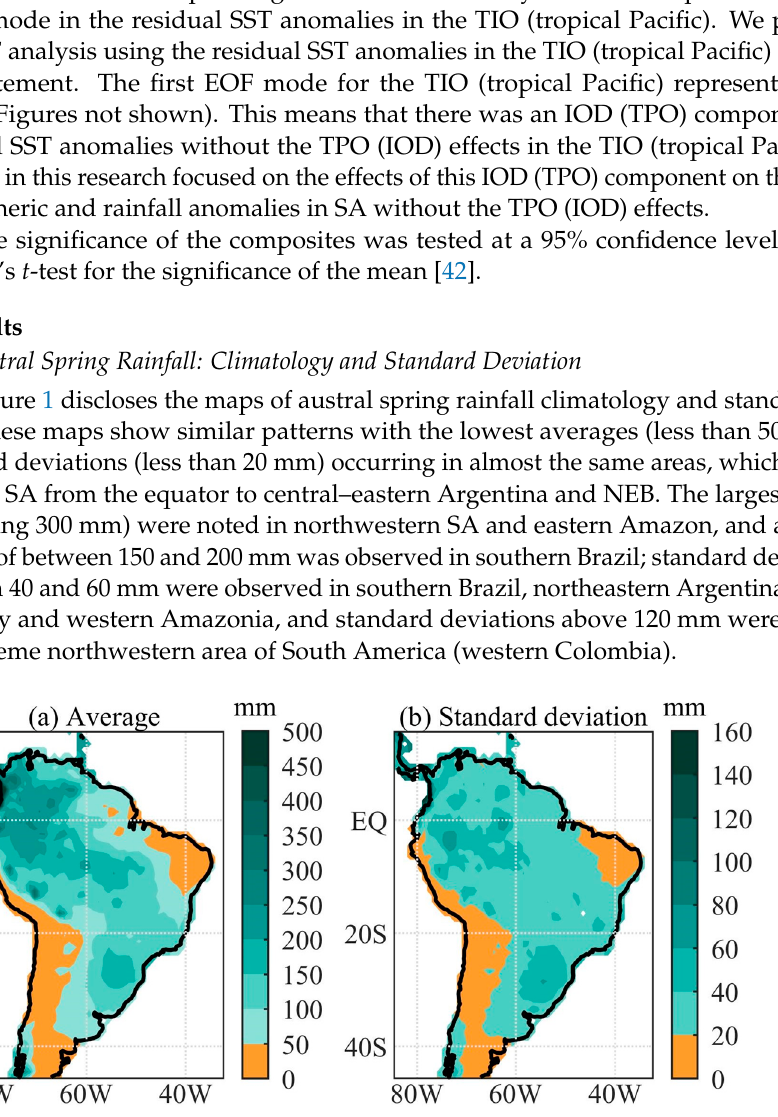
Figure 1. Austral spring rainfall: ( a ) climatology (mm); and ( b ) standard deviation (mm).